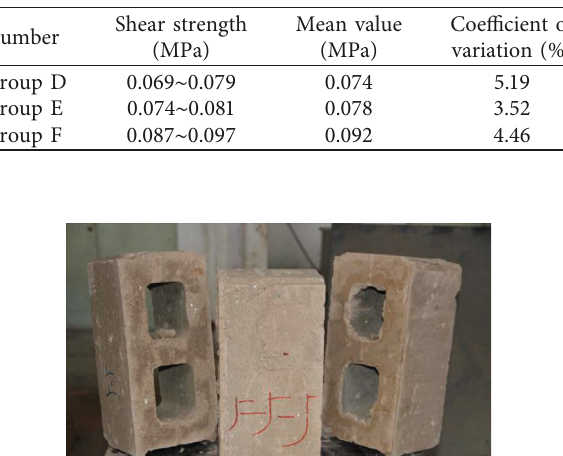
Table 9: The results of the shear tests of HCCSEB masonry prisms.